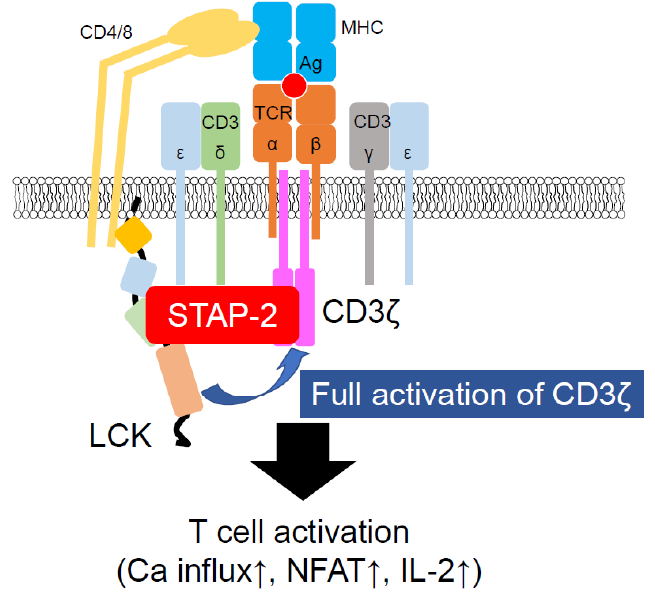
Figure 2. Participation of STAP-2 in LCK-mediated CD3 ζ activation. STAP-2 functions as an adaptor protein of LCK and CD3 ζ . Once these proteins bind to STAP-2, LCK easily phosphorylates CD3 ζ , resulting in the induction of T cell activation events, such as calcium mobilization and IL-2 production.